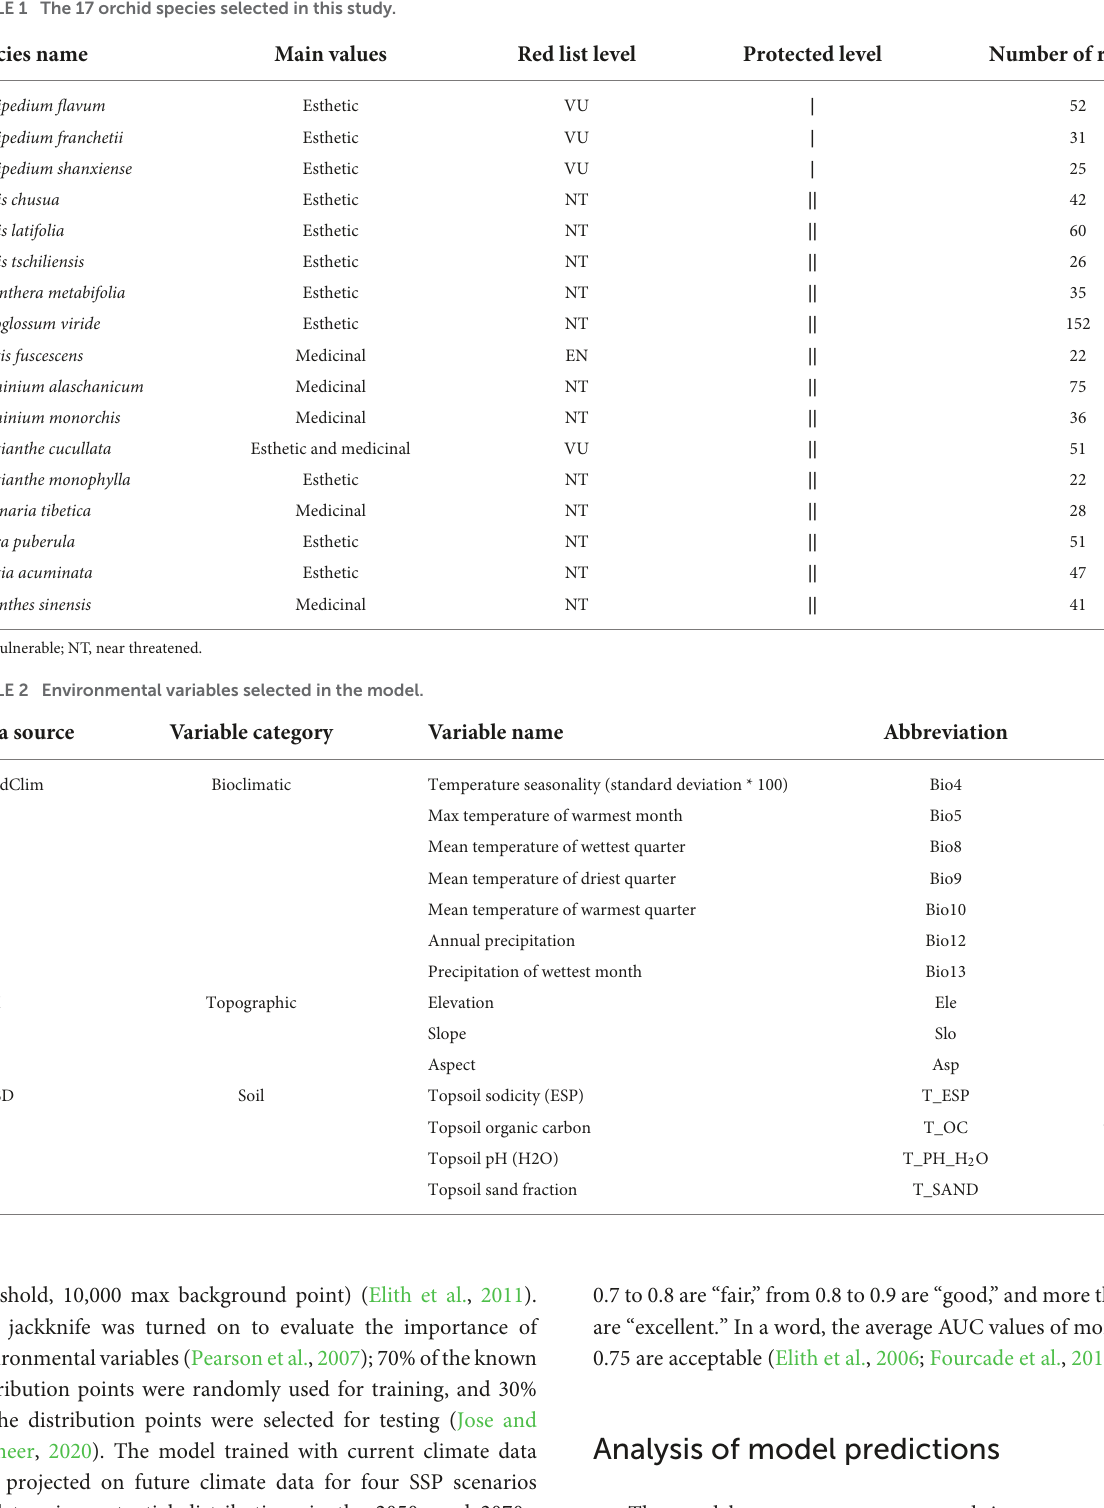
TABLE 1 The 17 orchid species selected in this study.